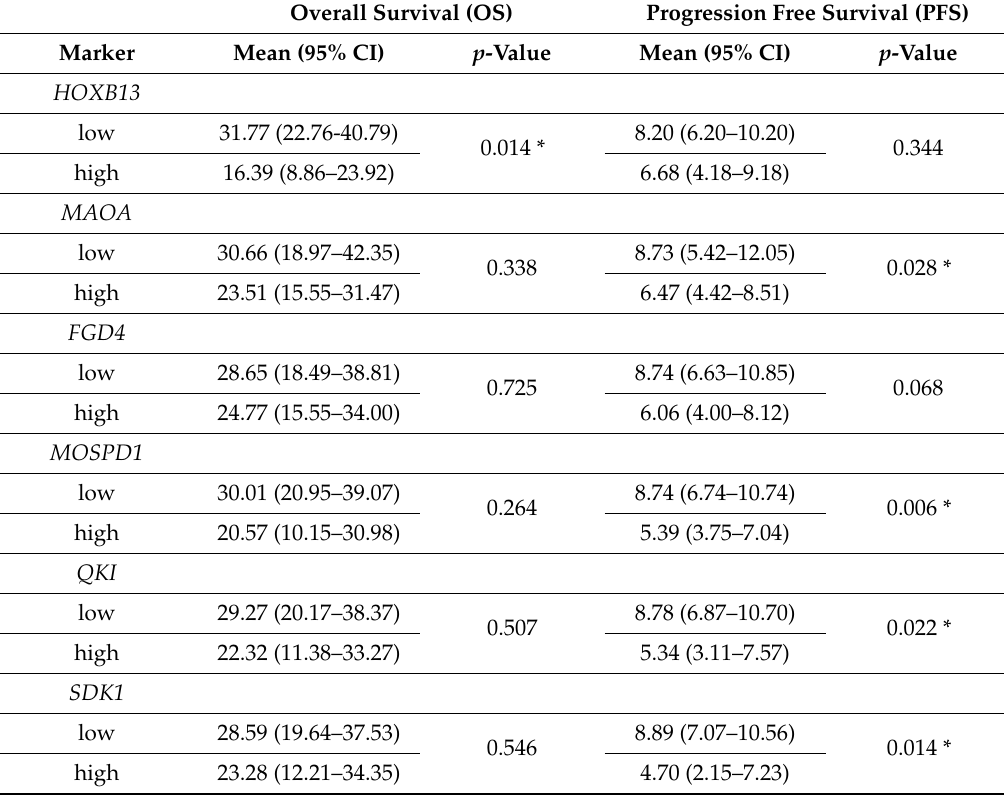
Table 2. Kaplan–Meier analysis for CTC